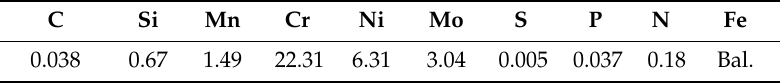
Table 1. Chemical composition of 2205 stainless-steel